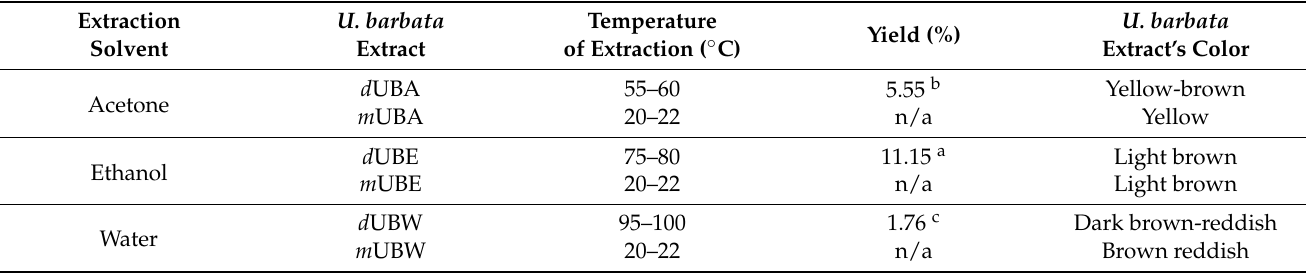
Table 1. Extraction conditions and U. barbata extracts